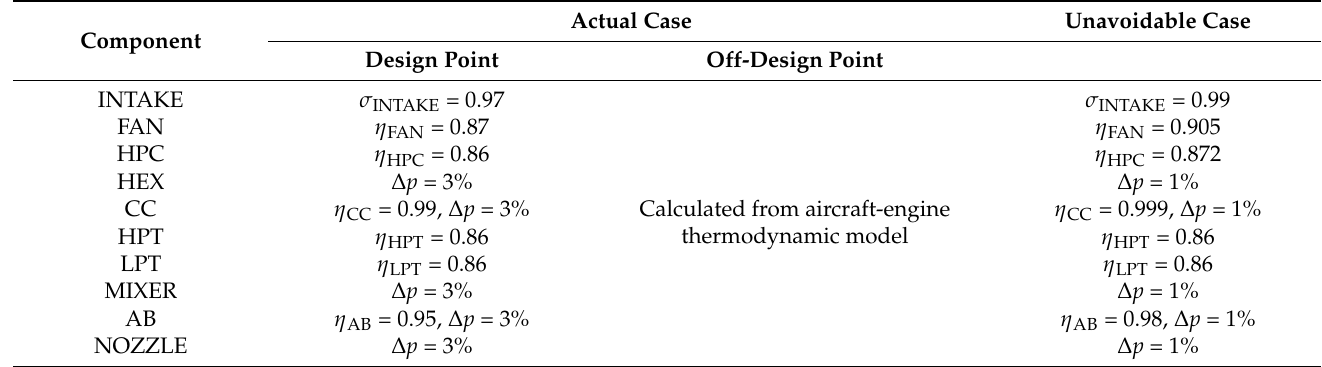
Table 4. Assumptions used for the avoidable and unavoidable exergy destruction calculations.